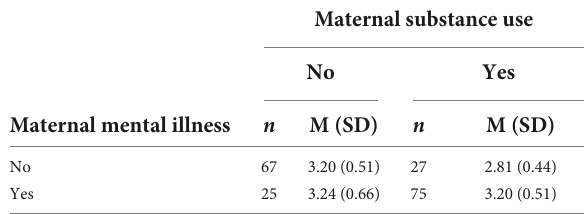
TABLE 2 Descriptive statistics for mothers’ mean RF by family history of maternal mental illness and maternal substance use.